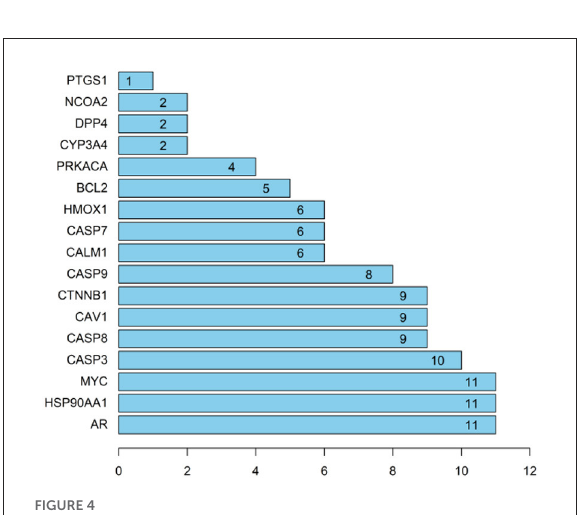
FIGURE4 Barplot showing significant genes in the PPI